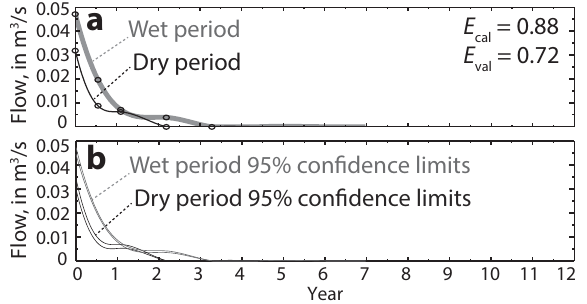
Figure 6. Example F8: nonparametric impulse-response functions (IRFs) for Barton Springs using a total of seven control points show- ing (a) optimized IRFs and (b) upper and lower 95% confidence limits for the IRFs.